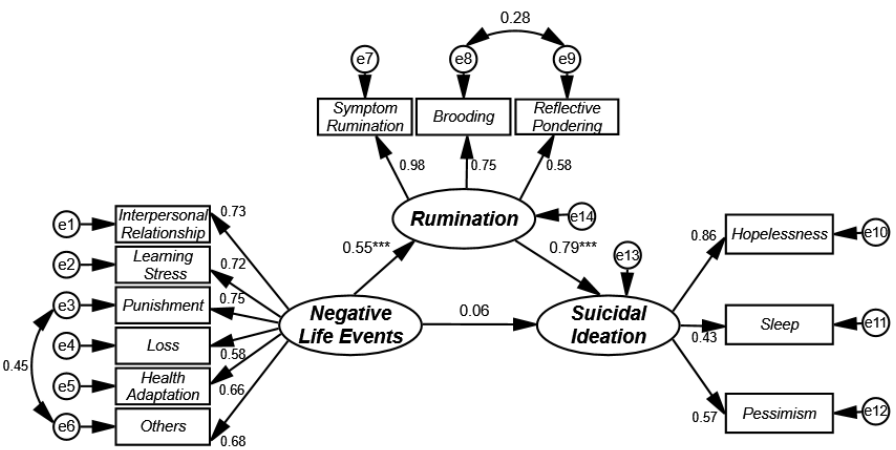
Figure 1. The model of the mediating effect of rumination in the influence of negative life events on suicidal ideation in college students. *** p <